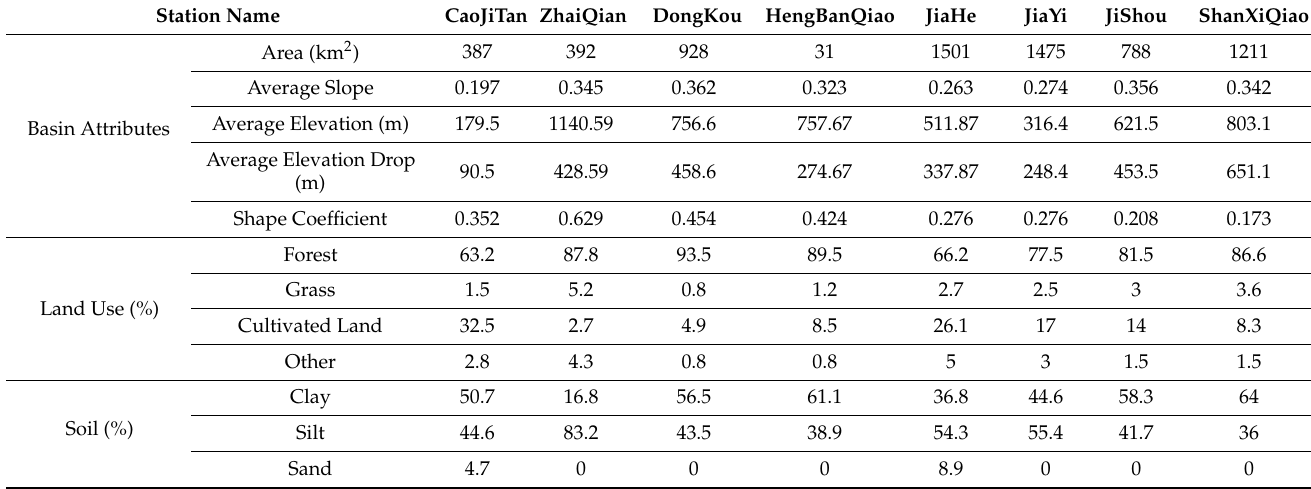
Table 8. Information on basin